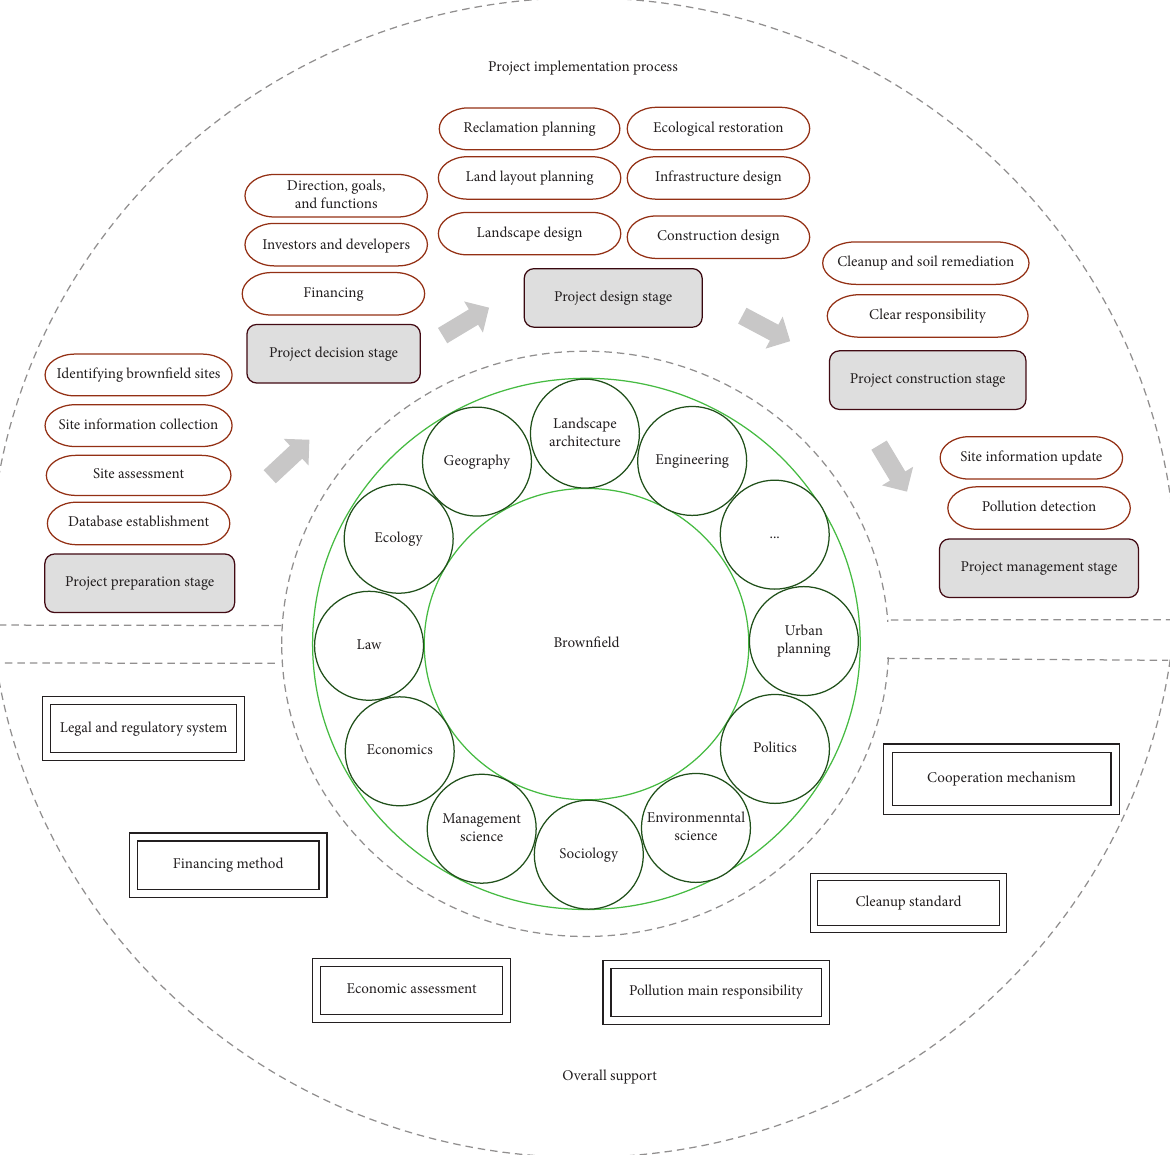
Figure 6: A framework for multidisciplinary integration on